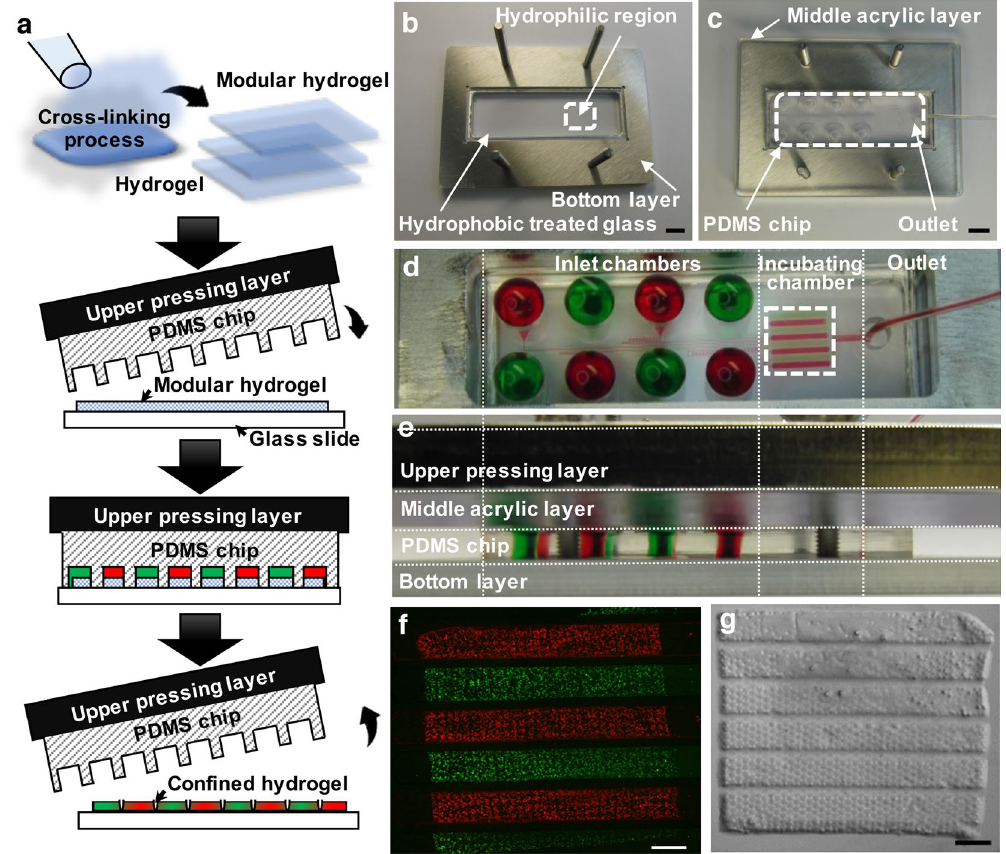
Figure 1. Overview schematic and images of a hydrogel-integrated microfluidic assembly platform. ( a ) Modular hydrogel sheets were massively fabricated and manipulated as a cell-carrying modular unit to incorporate them into a microfluidic device. After microfluidic reactions were performed, the structure of the partially treated modular hydrogel sheet was retained after removal of the microfluidic device. ( b , c ) Assembling process for a microfluidic channel layer (PDMS chip), covering the modular hydrogel sheet on the surface of the Teflon-coated glass slide. ( b ) The modular hydrogel sheet was placed onto the hydrophilic region on the CF 4 -coated glass slide. ( c ) The plasma-treated microfluidic channel layer was then covered onto the modular hydrogel sheet. Scale bar = 1 cm. The top ( d ) and side view ( e ) of the whole microfluidic assembly platform, where each liquid has been filled in the inlet chamber to control and withdraw the fluid toward the outlet side. The recovered modular hydrogel sheet was confirmed both from the fluorescent image ( f ) with two different colors (green or red CellTracker) and the bright-field image ( g ) of the pressed modular hydrogel sheet. Scale bar = 1